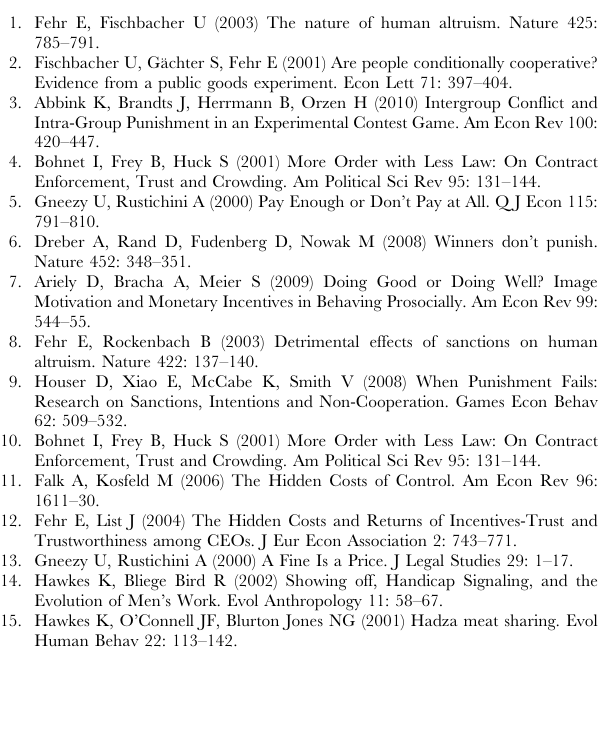
Table S1 Determinants of Approval Received. Table S1 shows that determinants of approval points received follow a similar pattern across the treatments. In particular, the greater (smaller) the contribution in relation to others, the greater (smaller) was the amount of approval a person received. The strength of this effect is identical among treatments. This is shown by the coefficient for ‘‘Treatment variable (Baseline/Mug/Ice-cream) 6 Positive/Negative Deviation from Others’ average.’’ Moreover, in all treatments, the group’s highest contributor is also a star winner with frequency at least 90%. (GIF) Table S2 Female Conditional Cooperation and Male Unconditional Generosity. First period contributions between Mug and Ice-cream are statistically identical among female co- operators (N = 12 for Mug; N= 15 for Ice-cream. z = 1.001, P =0.317); within Mug, however, significant differences emerge between female co-operators’ (mean =14.0, N= 12) and male co- operators’ in the first period (mean =17.4, N= 29, z = 2 2.356, P =0.019). Nevertheless, over time in Mug, female co-operators’ (N = 7 groups) contributions increase so that overall average contributions do not differ between male (N = 12 groups) and Table 2 provides evidence to support female conditional cooperation. We see that the coefficient for female conditional cooperation in Mug is 0.635 (z = 5.72, P = 0.000), which is